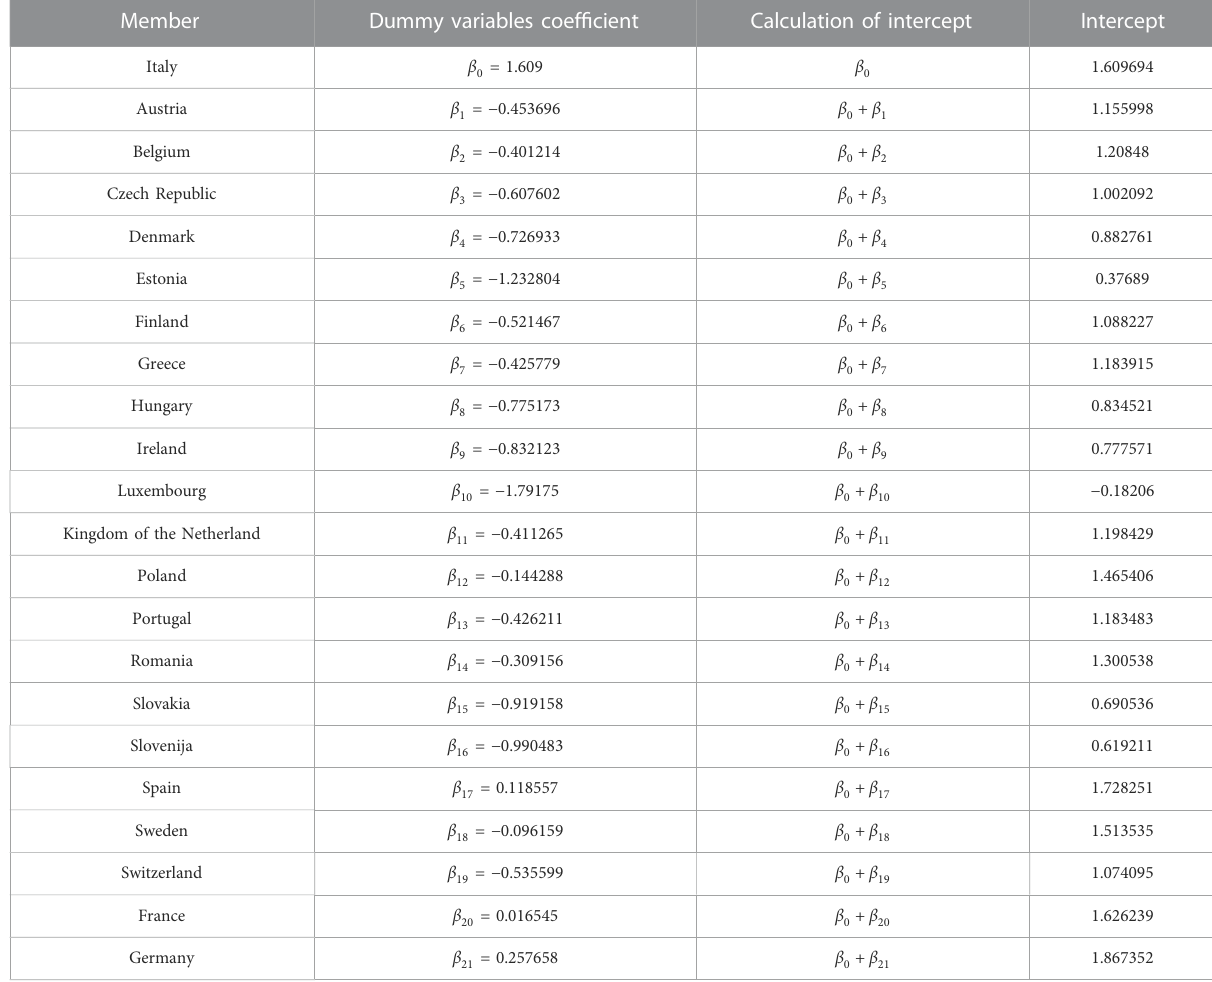
TABLE 9 Intercept calculation for each member of EU geopolitical